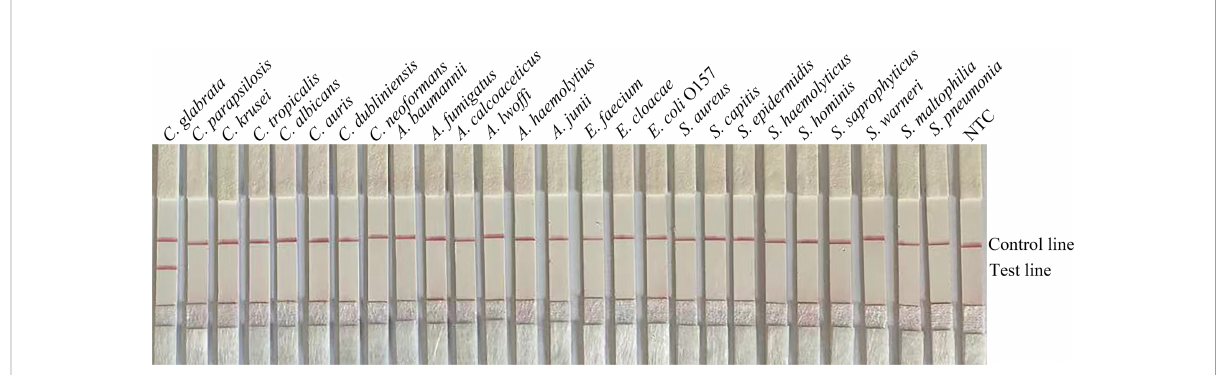
FIGURE 4 Speci fi city of F4/R2/P. C. glabrata ATCC 15126 was used as a positive control against other pathogenic bacteria tested, and species names are indicated at the top of each strip. NTC indicates no-template control. The positions of the test and control lines are marked on the right side of the bars. Reactions were performed at 37°C for 20 min. Images represent the results of three independent